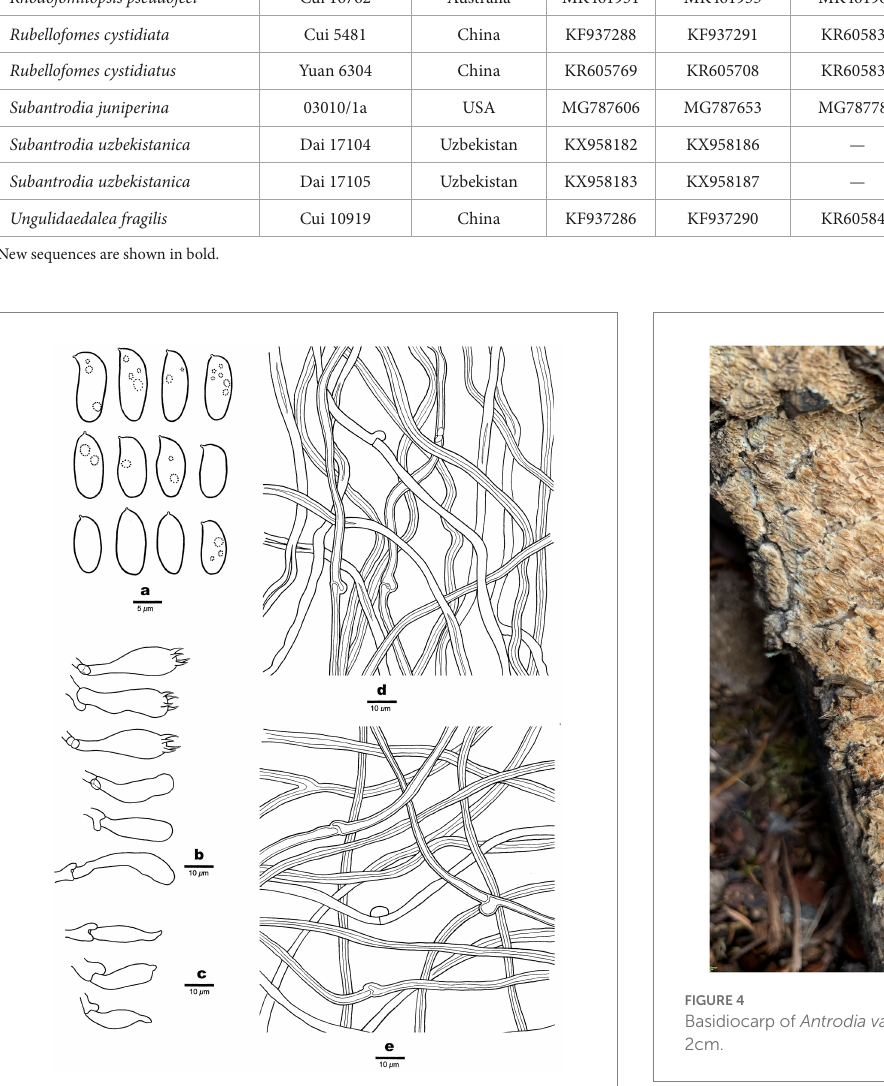
FIGURE 3 Microscopic structures of Antrodia aridula (holotype, Dai